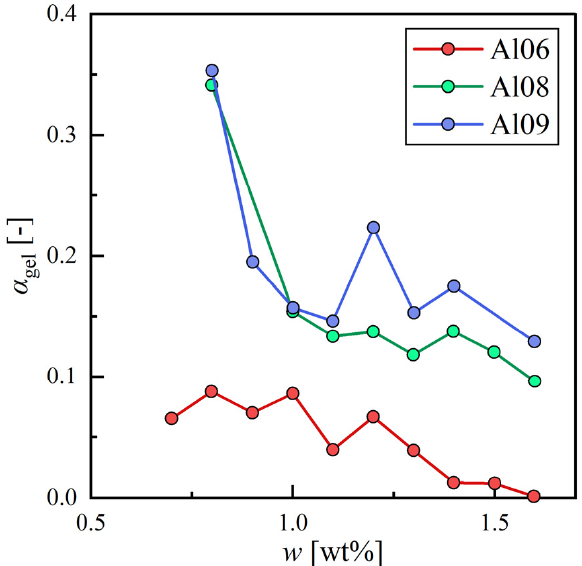
Figure 4. The degree of gelation with a weight fraction of 12HSA for hexane (Al06), octane (Al08), and nonane (Al09).